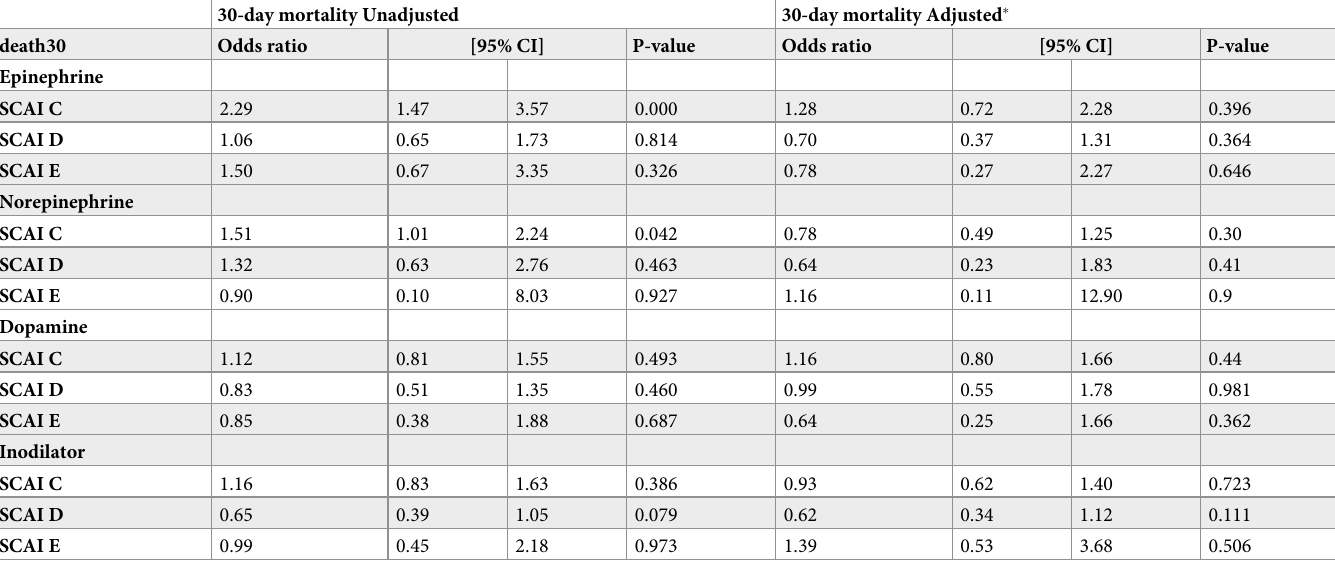
Table 5. Logistic regression on 30-days mortality. 30-day mortality